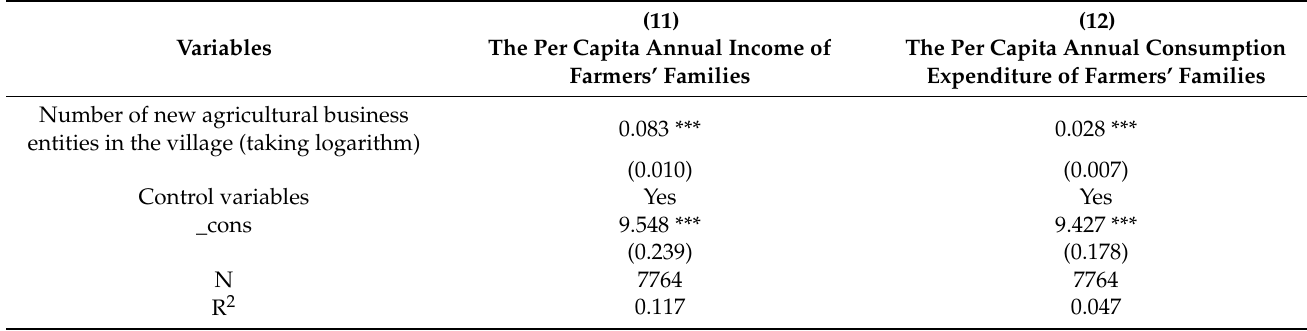
Table 8. Robustness test results of independent variable substitution